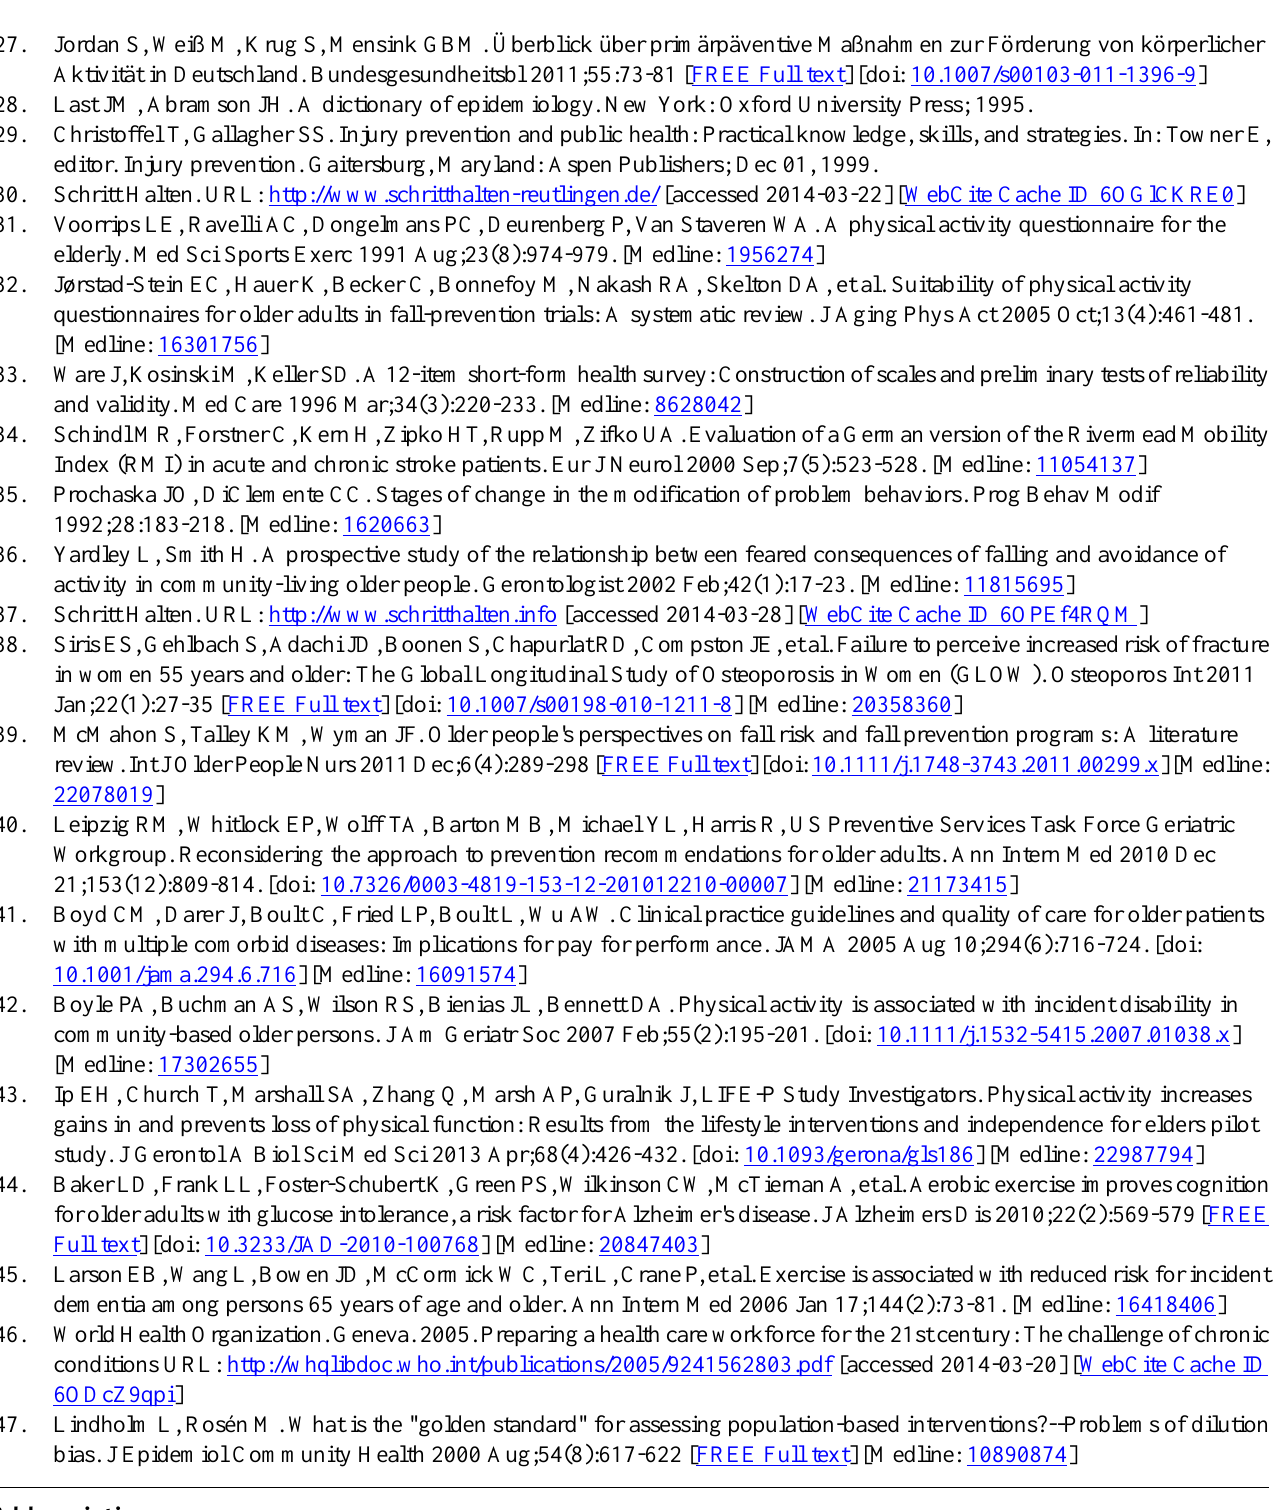
Abbreviations CDC: US Centers for Disease Control and